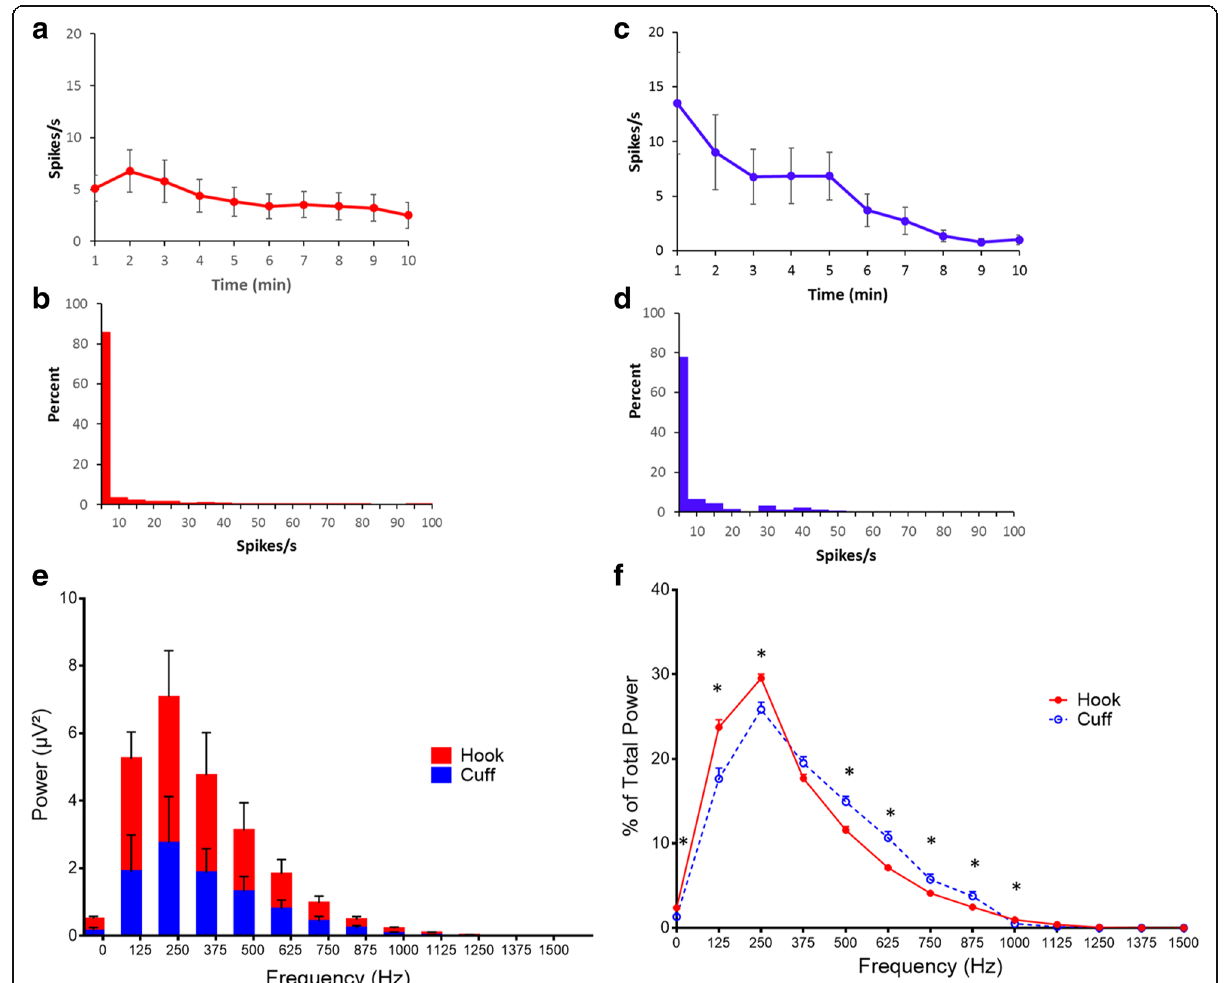
Fig. 3 Comparison of neural activity recorded with hook and cuff electrodes. a Spikes rate of the neural events recorded with the hook electrode. b Rate distribution was calculated as overall percent of spike rate within 1 min segments over the 10-min recording with hook electrode. c Spikes rate of the neural events recorded with the cuff electrode. d Rate distribution was calculated as overall percent of spike rate within 1 min segments over the 10-min recording with cuff electrode. e FFT analysis of the 10 min recordings obtained with hook (red) or cuff (blue) electrode (Two-way ANOVA p =0.0003). f Percentage breakdown of the frequencies recorded with the hook (red, closed circle solid line) and cuff (blue, open circle, dashed